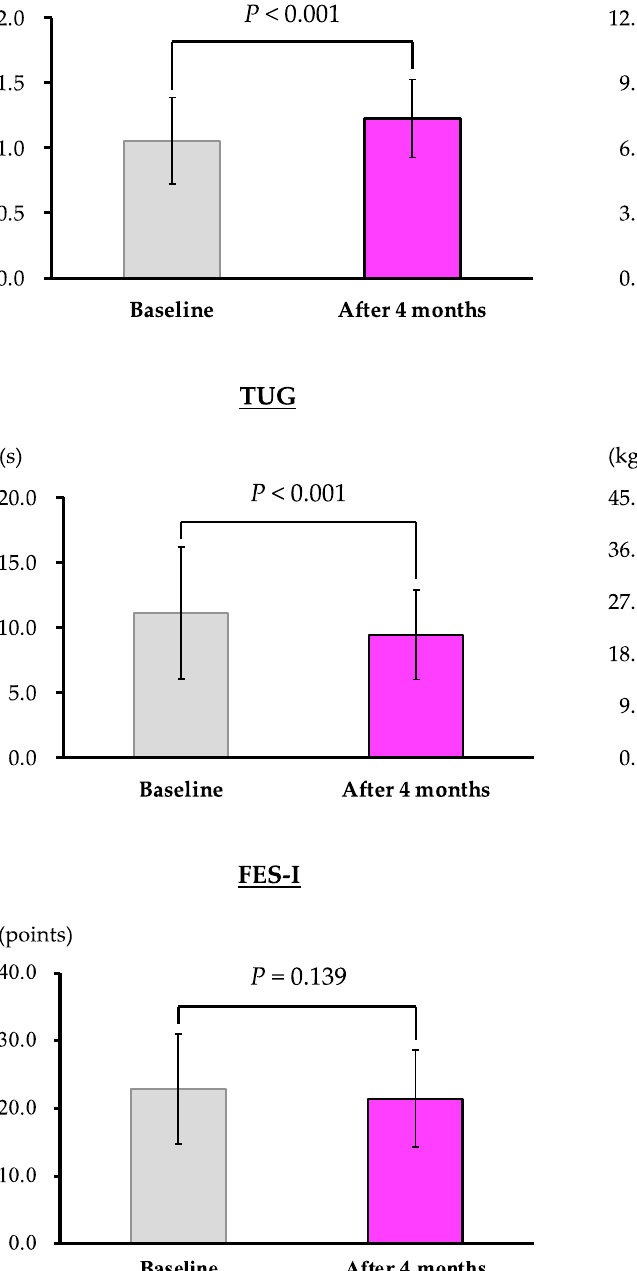
Figure 3. Intervention effect of CR including BEAR exercises (all patients). Changes in 10 m gait test (gait speed), Short Physical Performance Battery score (SPPB), timed up-and-go (TUG) test, muscle strength of knee extension (knee extension), and fear of falling (Fall Efficacy Scale—International, FES-I).